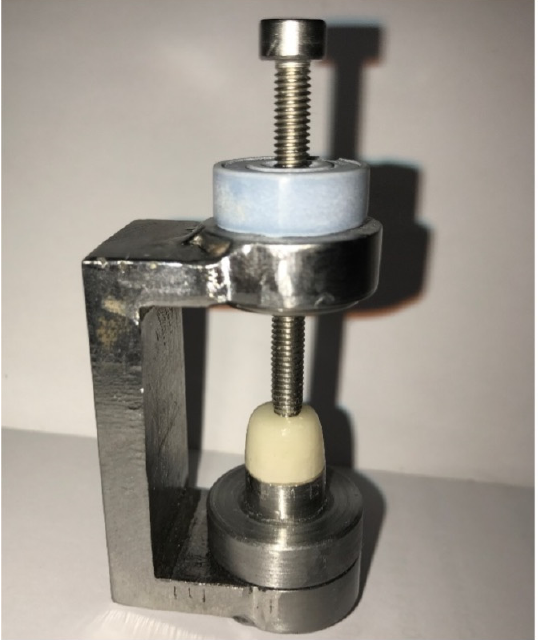
Figure 5. The stabilizing instrument.